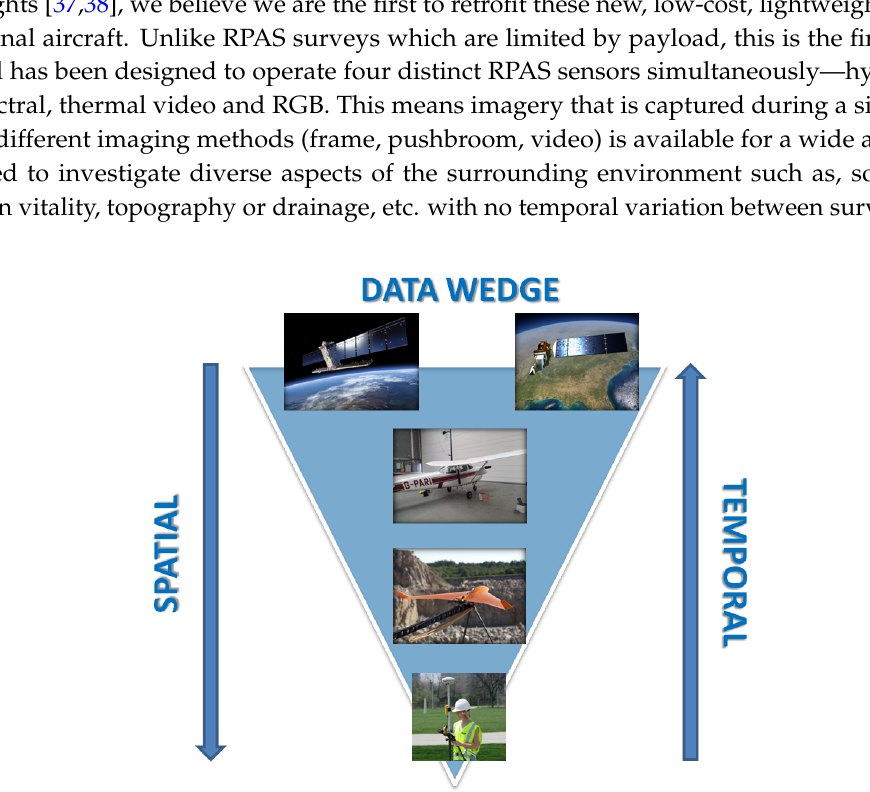
Figure 1. Data Capture at multiple resolutions: Earth orbiting satellite, light aircraft, Remotely Piloted Airborne Systems (RPAS) and field